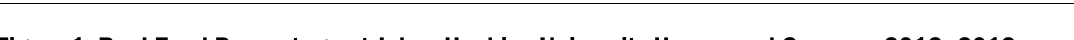
Figure 1. Real Food Percentage at Johns Hopkins University Homewood Campus, 2012 – 2019 Figure 1 shows the percentage of the university’s food procurement budget that was spent on “Real Food” for each school year of the Real Food Commitment. Although the 2019/20 school year was part of the JHU Real Food Commitment, data were unavailable due to the premature ending of the school year during the COVID-19